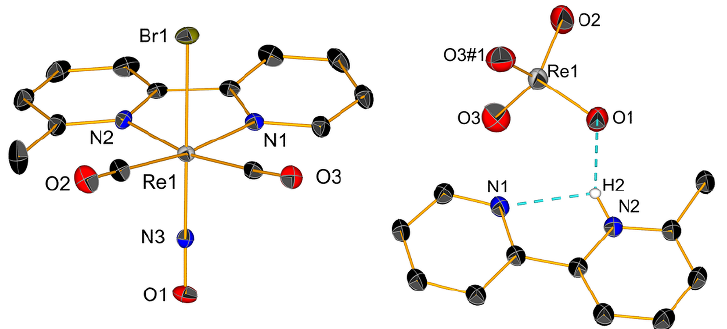
Figure 8. Crystal structures of compounds 14 (left) and its fully oxidized product. Thermal ellipsoids are at 30% probability. Hydrogen atoms and BF 4 − counter ion omitted for clarity. Selected bond lengths for 14 (Å): Re-N1 2.135(4), Re-N2 2.188(4), Re-N3 1.784(4), Re-Br 2.5358(5), Re-CO 2.006(5) and 1.975(5), C-O 1.120(6) and 1.135(6), N-O 1.161(5). Selected bond angles ( ◦ ): 14 , O1-N3-Re1